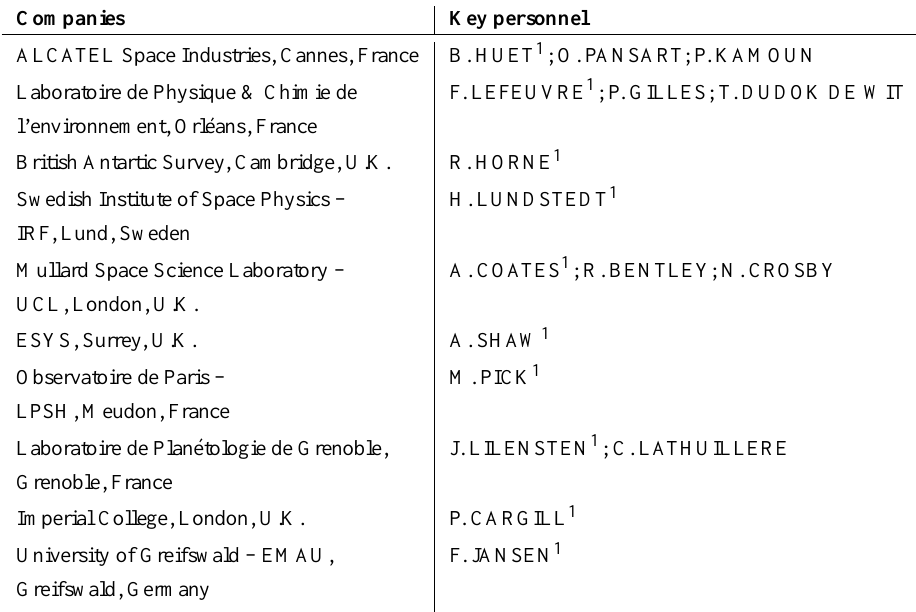
Table A1: Members of the consortium lead by ALCATEL Space and LPCE